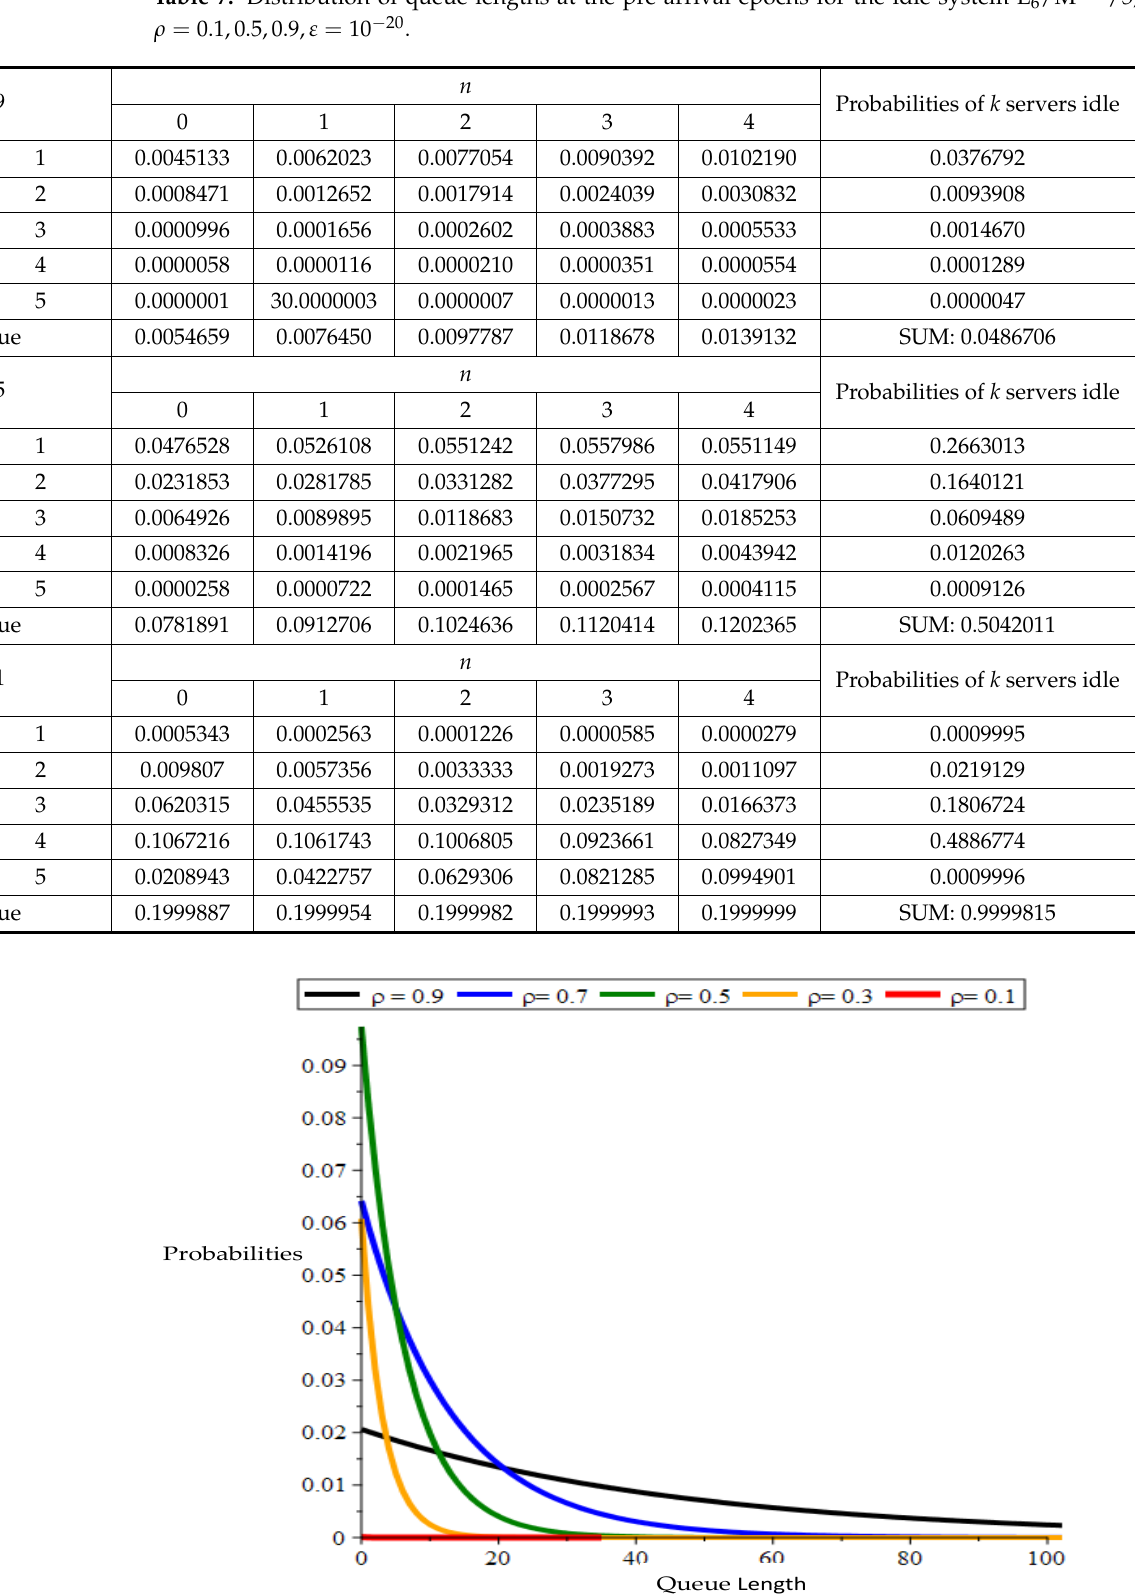
Table 7. Distribution of queue lengths at the pre-arrival epochs for the idle system E 6 /M 5,10 /5,